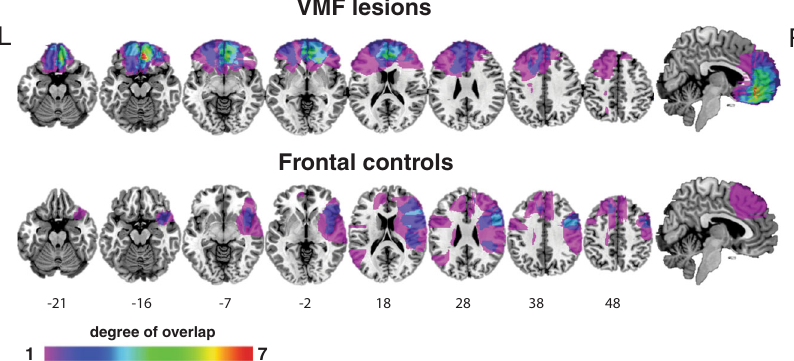
Fig. 1 | Overlap of lesions in the VMF and frontal control groups. Numbers below slices indicate the MNI z-coordinates. Colors indicate extent of overlap. L=left;